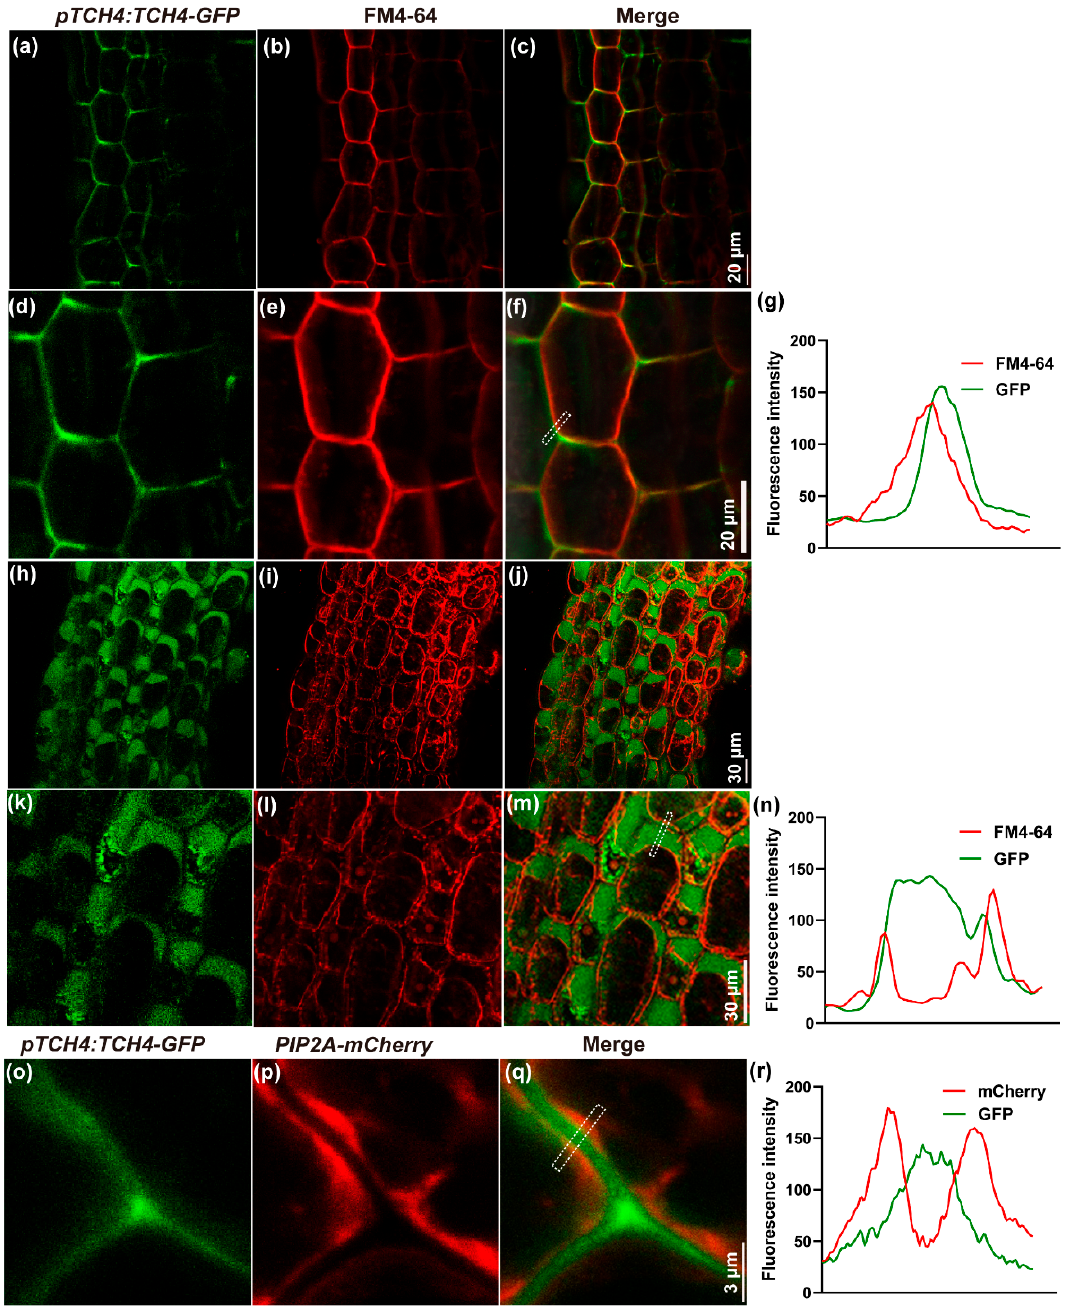
Figure 2. Subcellular localization of AtTCH4 in Arabidopsis hypocotyls and tobacco cells. ( a , d ) The confocal image of pTCH4:TCH4-GFP fusion proteins in Arabidopsis hypocotyls. ( b , e ) FM4-64 (plasma membrane marker) localization in the same hypocotyls cells as in ( a ). ( c , f ) pTCH4:TCH4-GFP colo- calized with FM4-64. ( d – f ) are enlarged images of ( a – c ), respectively. ( g , n , r ) Plot profile analysis of pTCH4:TCH4-GFP (green) and FM4-64 (red) signals in the marked position shown in ( f , m , q ), respectively. ( h – m ) The localization of ( h , k ) pTCH4:TCH4-GFP , ( i , l ) FM4-64, and ( j , m ) colocalized localization in plasmolyzed hypocotyls cells in Arabidopsis . ( k – m ) are enlarged images of ( h – j ), respectively. ( o – q ) The localization of ( o ) pTCH4:TCH4-GFP , ( p ) PIP2A-mCherry , and ( q ) colocalized localization in plasmolyzed tobacco